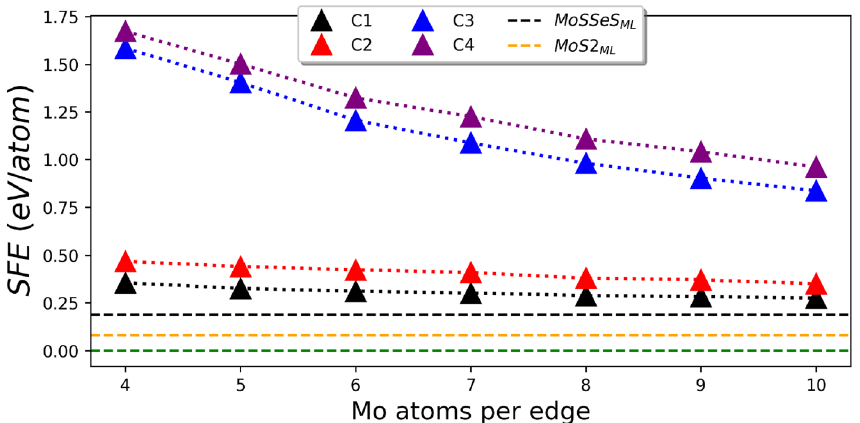
Figure 2. SFE for the four proposed triangular MoSSe quantum dots. C1, C2, C3, and C4 are represented by Bulk black, red, blue, and purple triangles. The MoS 2 is set as the reference and is depicted as a dotted green line. Over the reference, the MoS 2 and MoSSe MLs are represented by an orange and black dotted